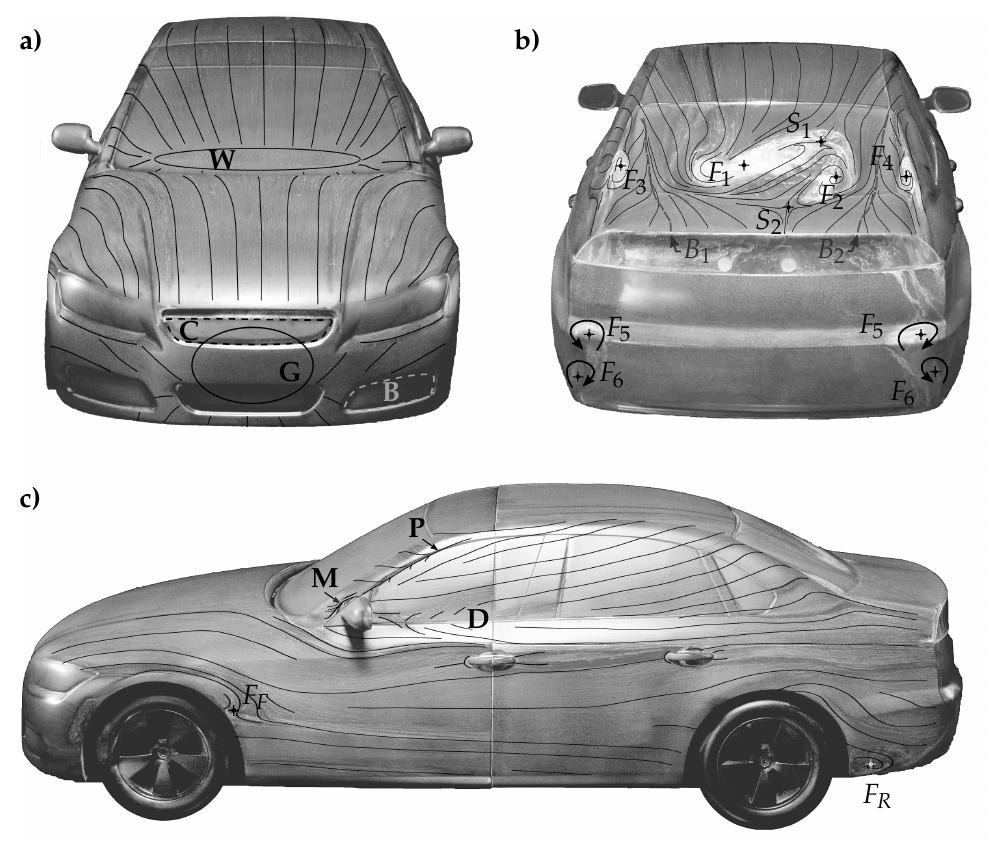
Figure 4. Surface traces at β = 0 ◦ in the frontal view ( a ), rear view ( b ), and side view ( c ). The surface traces on the model front are side-symmetrical and characterized by two stagnation points. One is located on the lower windshield and another is on the lower grille. Both are indicated by W and G , respectively. However, it is not possible to depict the exact locations, as almost no oil traces are visible within the areas. A closer examination of the front fascia reveals further stagnation lines located on the side and center grills, as shown by the dashed lines B and C , respectively. However, these can be attributed to the closed grill design of the model that prevents any